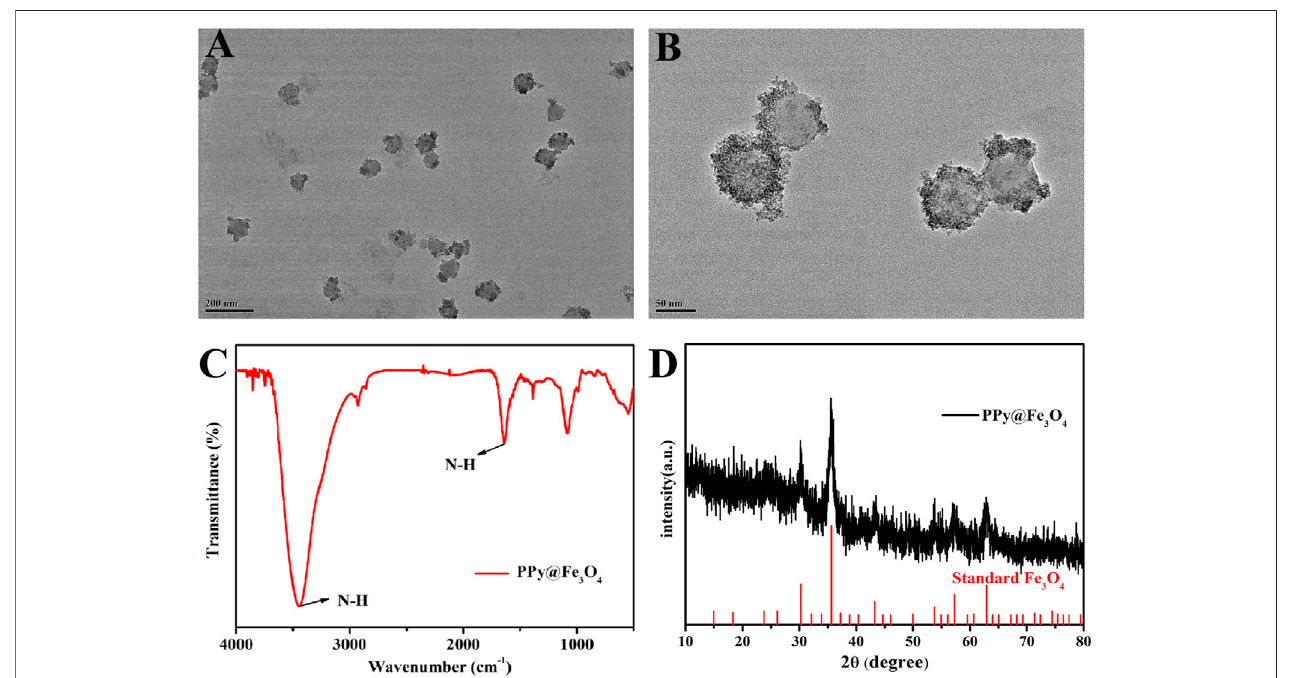
FIGURE1| ThecharacterizationofPPy@Fe 3 O 4 NPs. (A) Low-and (B) medium-magni fi cationTEMimageofthePPy@Fe 3 O 4 NPs. (C) FTIRspectraofPPy@Fe 3 O 4 NPs. (D) XRD spectra of PPy@Fe 3 O 4 NPs.